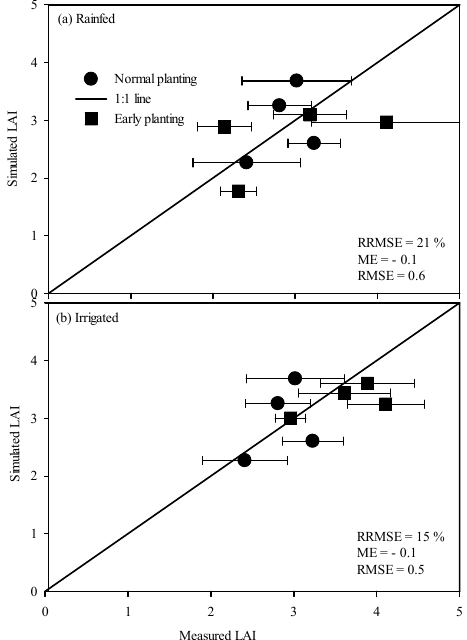
Figure 2. Measured and simulated cotton leaf area index (LAI) of normal and early plantings under rainfed ( a ) and irrigated ( b ) conditions during 2005–2008 (four data ‐ points each per planting date) at Stoneville, MS. Error bars indicate one standard deviation (SD) from the mean of the measured LAI across the four treatment replications.